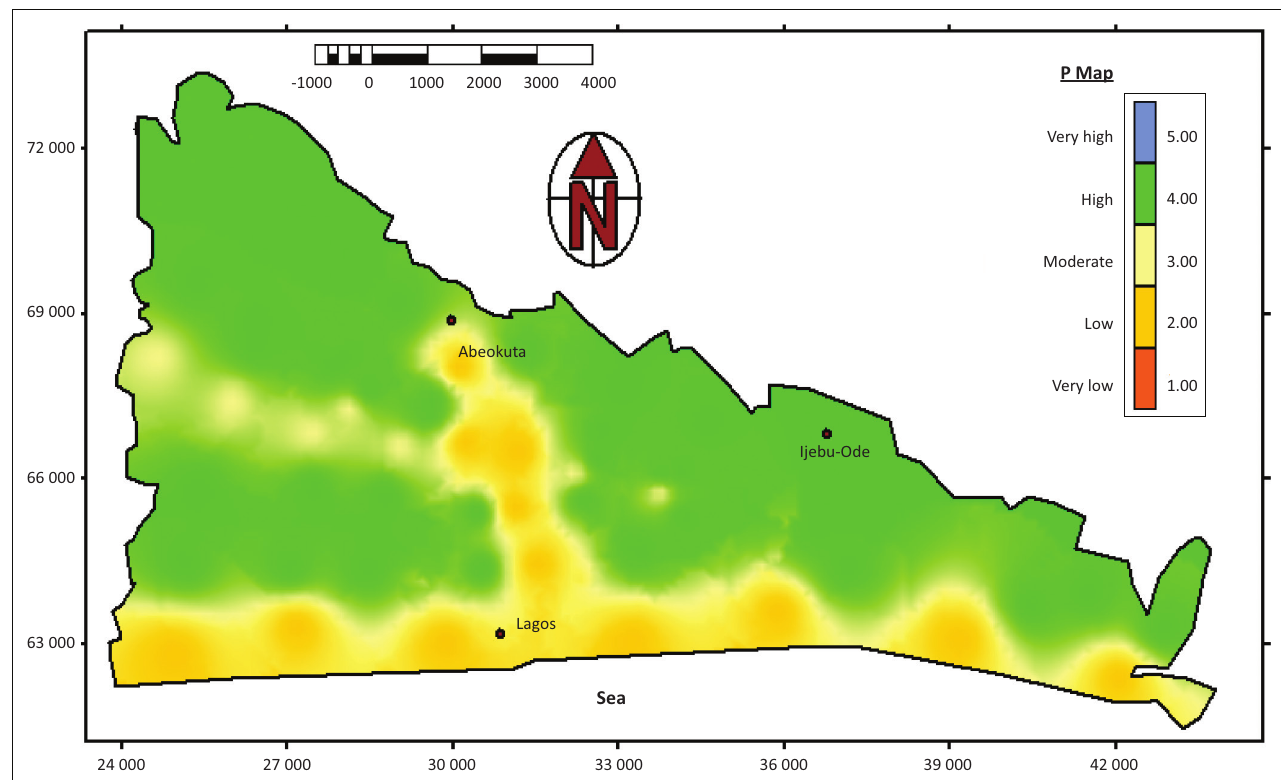
FIGURE 3: Protective cover map of sedimentary basin of southwestern